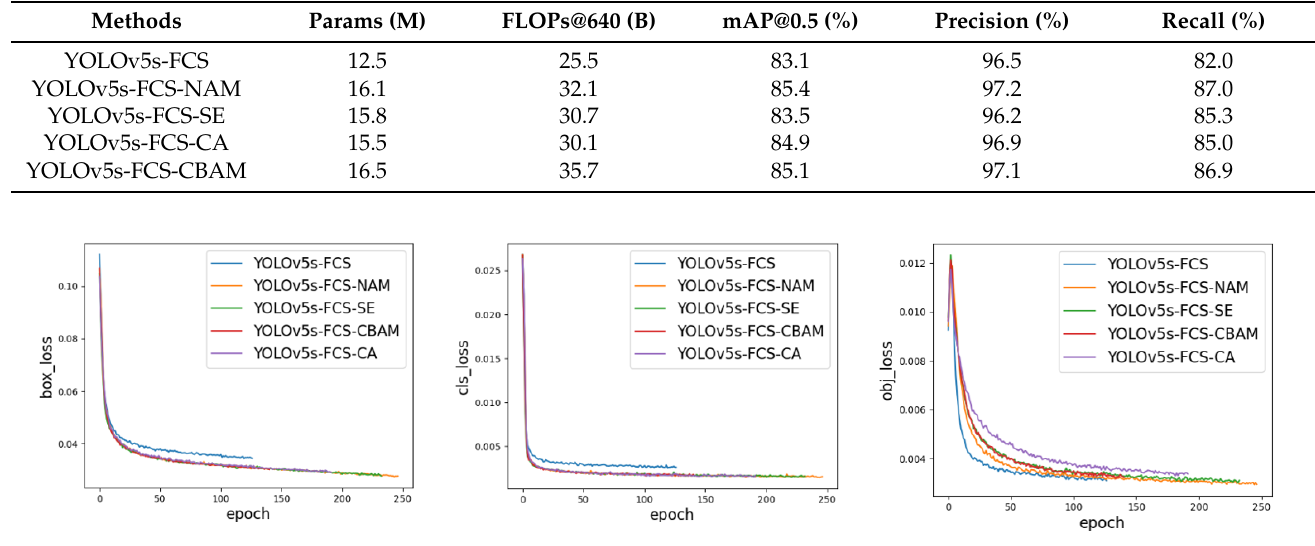
Table 2. Comparison of multi-scale YOLOv5 models’ performances with different attention mechanisms.